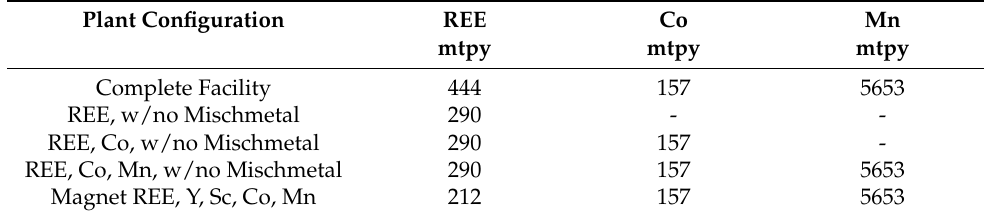
Table 7. Annual REE/CM production for various operational